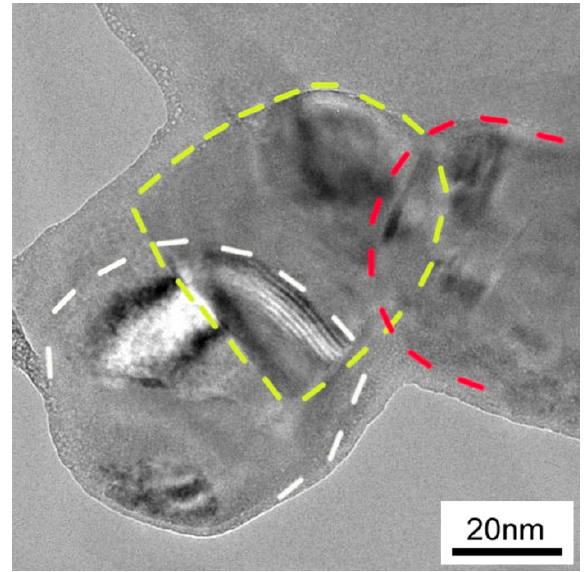
Figure 6. High ‐ resolution transmission electron microscopy (HRTEM) image of a C 60 particle in the C 60 /Cu 2 SnSe 3 composite.